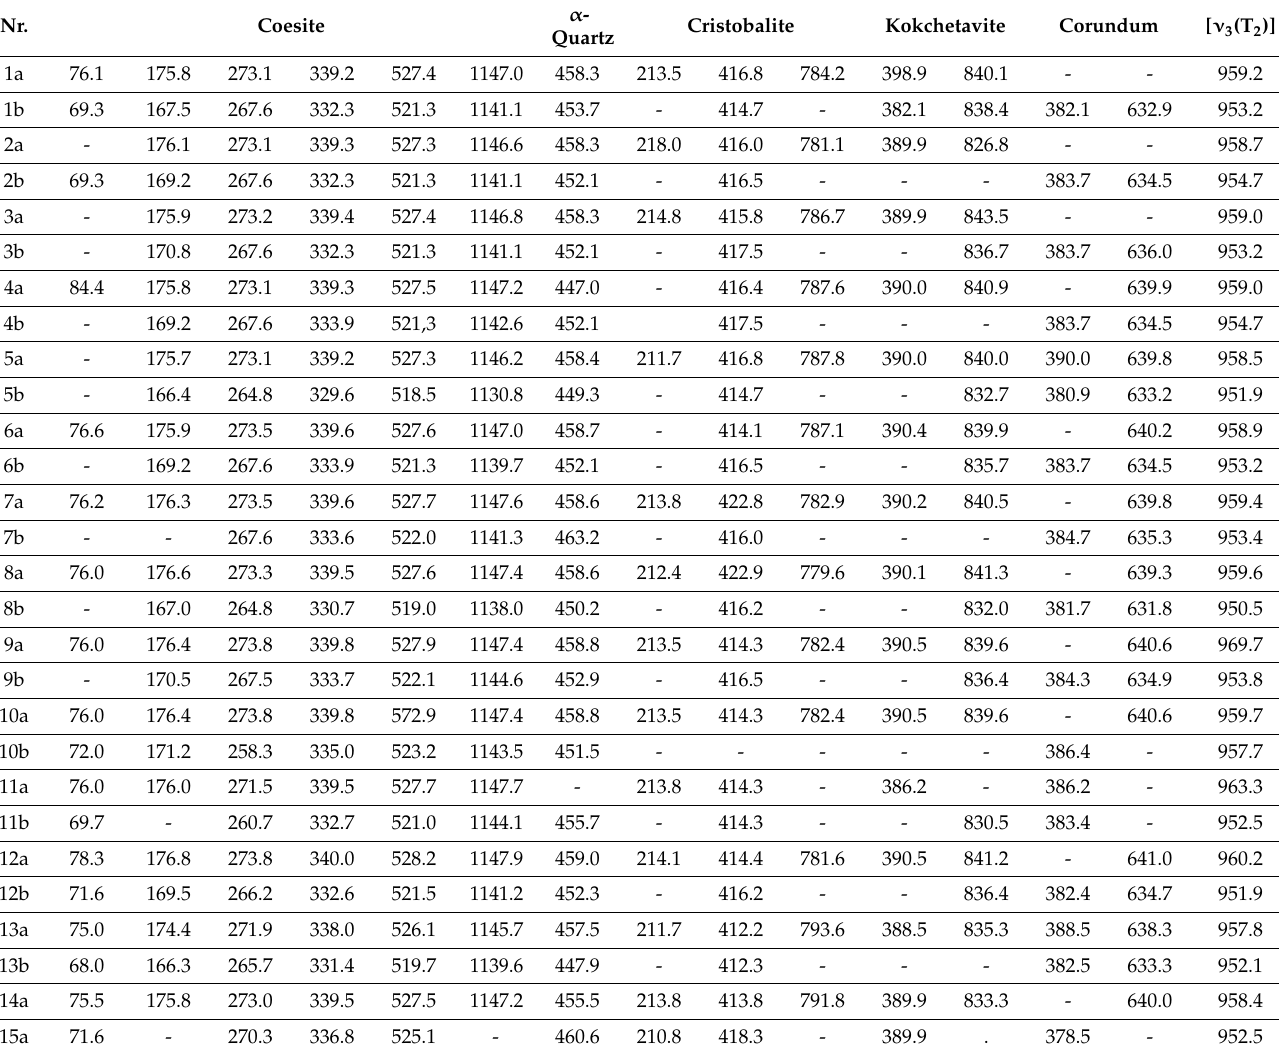
Table 1. Raman bands of coesite-I in prismatine from Waldheim. Besides the coesite bands, some bands can be assigned to quartz, cristobalite, kokchetavite, and corundum. Numbers in the first column levelled with a and b represent data taken using 28 mW and 5 mW, respectively. These different laser energies are responsible for the generally observed blue shift of the Raman bands in the Waldheim coesite. Note that such a blue shift was never observed in synthetic stishovite or